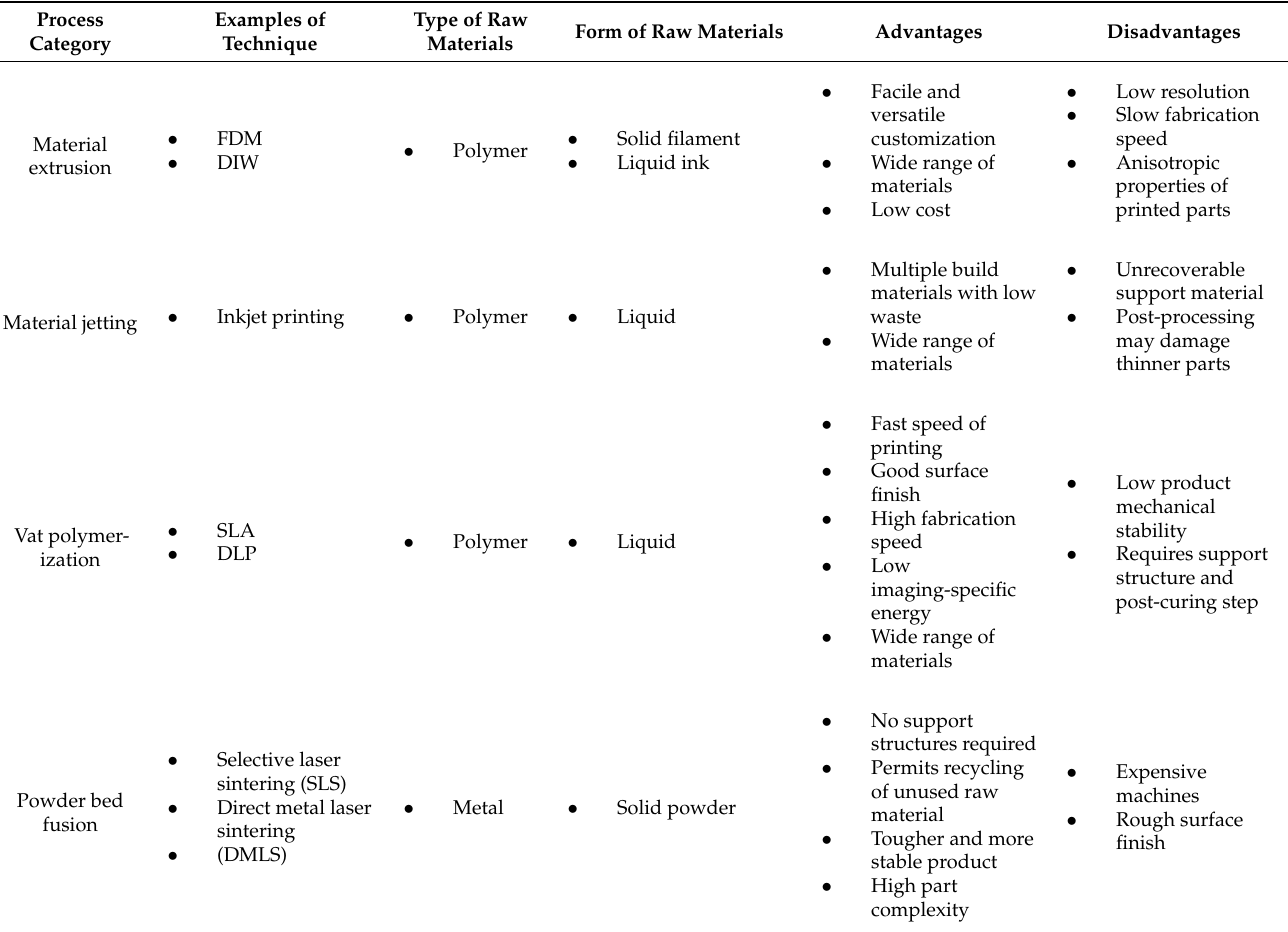
Table 1. Categories of additive manufacturing processes, examples of techniques, forms of raw materials, and advantages and disadvantages